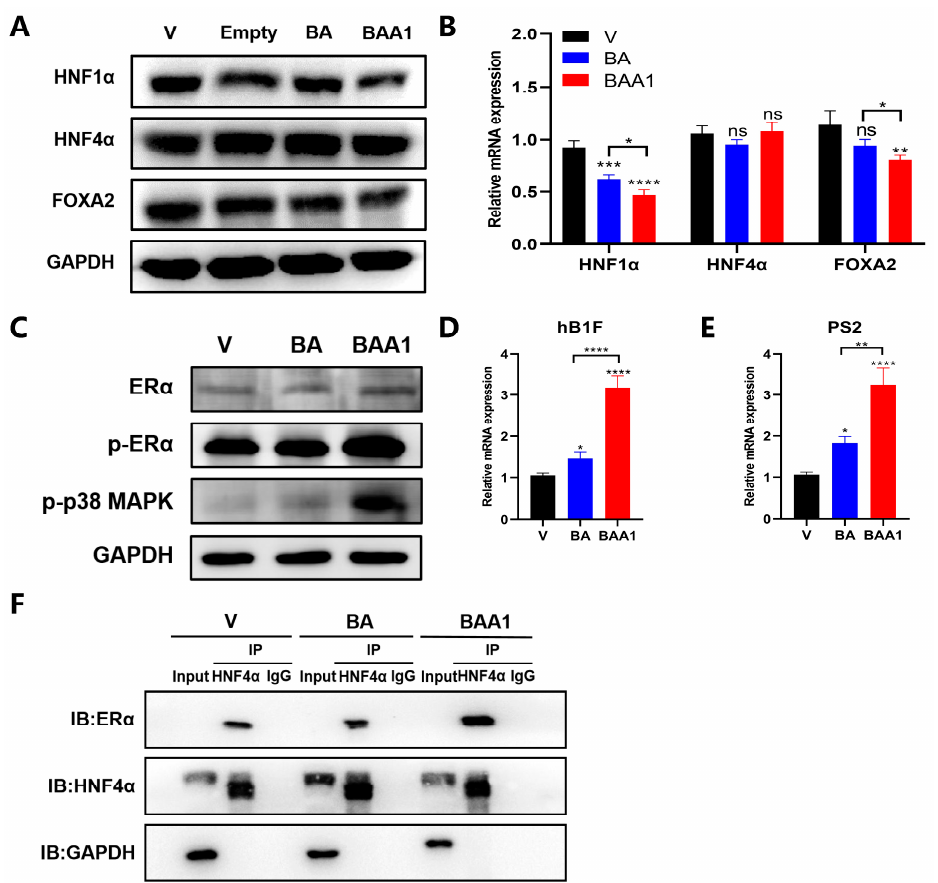
Figure 6. Liver-enriched transcription factors were influenced by BAA1 treatment. pHBV1.2-HepG2 cells were treated with BA (50 μ M) or BAA1 (50 μ M) for 4 days. ( A , C ) HNF1 α , HNF4 α , FOXA2, Er α , p-ER α , and p-p38 MAPK expression in pHBV1.2-transfected HepG2 cells (Western blotting). ( B , D , E ) the relative mRNA levels of HNF1 α , HNF4 α , FOXA2, hB1F, and PS2 (qRT-PCR). Data are presented as mean ± SD, n = 3; * p < 0.05, ** p < 0.01, *** p < 0.001, and **** p < 0.0001 vs. control. ns, not significant. ( F ) The combination of ER α and HNF4 α in pHBV1.2-transfected HepG2 cells was detected by Western blotting.